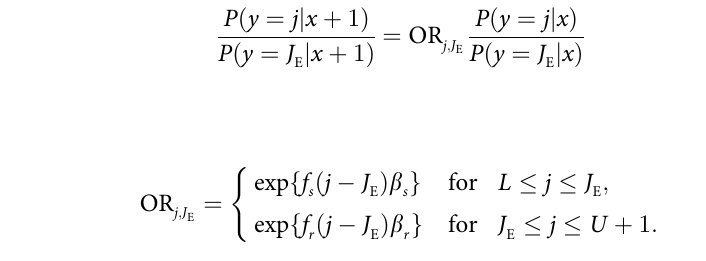
The other curves show the changes one year later, according to three models. The particular values assigned to the parameter of the models were inspired, though not equal by those of the CIPR data analysis (the effects were taken larger to show them more clearly). Model 7 with f ( x ) = 0, f ( x ) = x (solid black) corresponds to no changes over time in the s r � � in the susceptible component of the distribution (left of the ECOFF, red and solid black curves are identical in the lower panel) and a positive effect on the resistant compo- nent (right of the ECOFF, black curve lays above the red curve in the lower panel). The log odds ratios (LOR) ( j − J ) β show the increase over time x + 1 (one year later), with a linear E r increase of this effect over j − J = 1, 2, 3, 4. This latter linear increase over j (with values E 1.10,2.21,3.31,4.41) is shown by the short black solid vertical lines at the horizontal axis in the lower panel of Fig 1 (with scale indicated in the right vertical axis). The corresponding MIC distribution for model 7 one year later is shown in the above panel (solid black). It shows a pronounced increase of probabilities for the larger categories in the resistant component. Model 8 (dashed black curves) is similar to model 7 (no changes in the logits at the susceptible side), but the increase, now equal to LOR β , is constant over j . The constant increase 2.59 is r shown by the short black dashed vertical lines at the horizontal axis in the lower panel. Model 12 is also similar to model 7, but at the right resistant side. This model however represents a decrease at the susceptible side as well, expressed by the LOR’s ( j − J ) β with now j − J = − 1, E E s − 2, − 3. This latter linear decrease over j (with values -1.65,-1.10,-0.55) is shown by the short blue solid vertical lines at the horizontal axis in the lower panel. How such changes in the logits reflect changes in the MIC distribution is shown in the upper panel. Note that if more proba- bility is assigned to the resistant component on the right, less probability is automatically assigned to the left susceptible component (as observable in the upper panel of Fig 1). Model (7) implies particular odds ratio interpretations of the effect parameters β , β , for s r different 2 × 2 tables, as indicated by Table 1. Starting with the baseline odds, we have the rela- tion between the odds corresponding with a unit increase in time x :